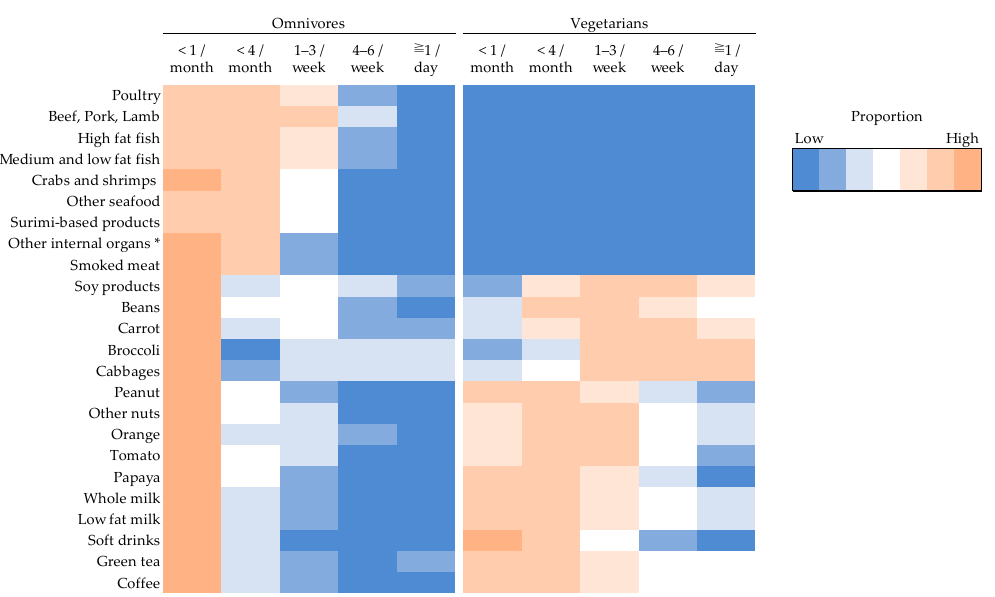
Figure 2. Heatmap of food intake in omnivores and vegetarians. Rows: food items; Columns: frequency of food intake in two groups. * Other internal organs include kidney, intestines, stomach, heart.